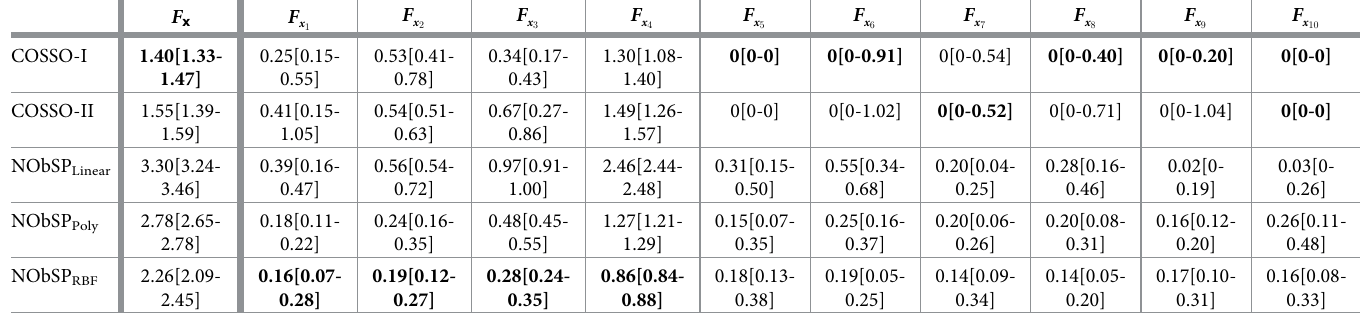
Table 1. Root mean square error for regression models and the estimation of the true functional forms using NObSP with three different kernels, COSSO-I, and COSSO-II. Values are expressed as median [min-max]. F